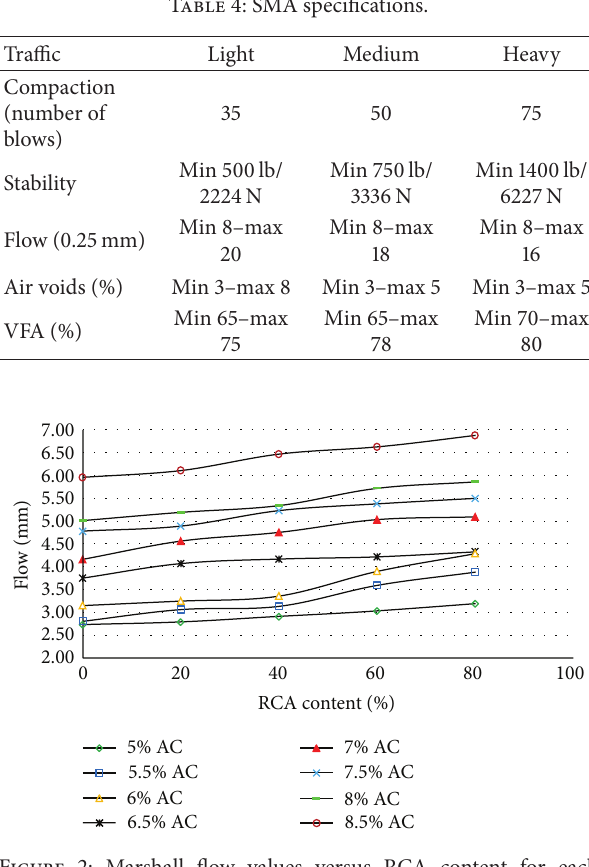
Figure 2: Marshall flow values versus RCA content for each percentage of asphalt